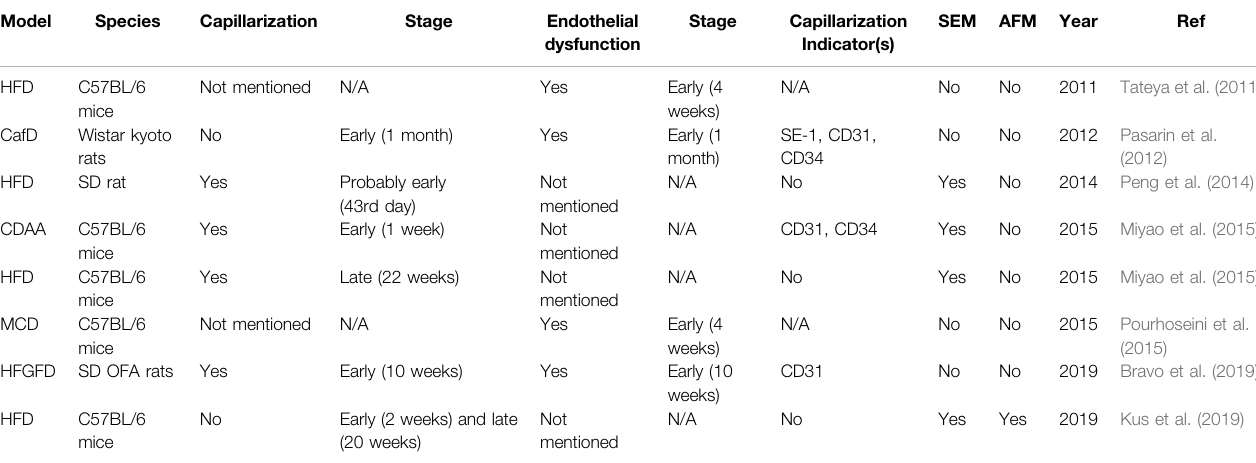
TABLE 1 | Summary of capillarization and endothelial dysfunction of LSECs in NAFLD animal